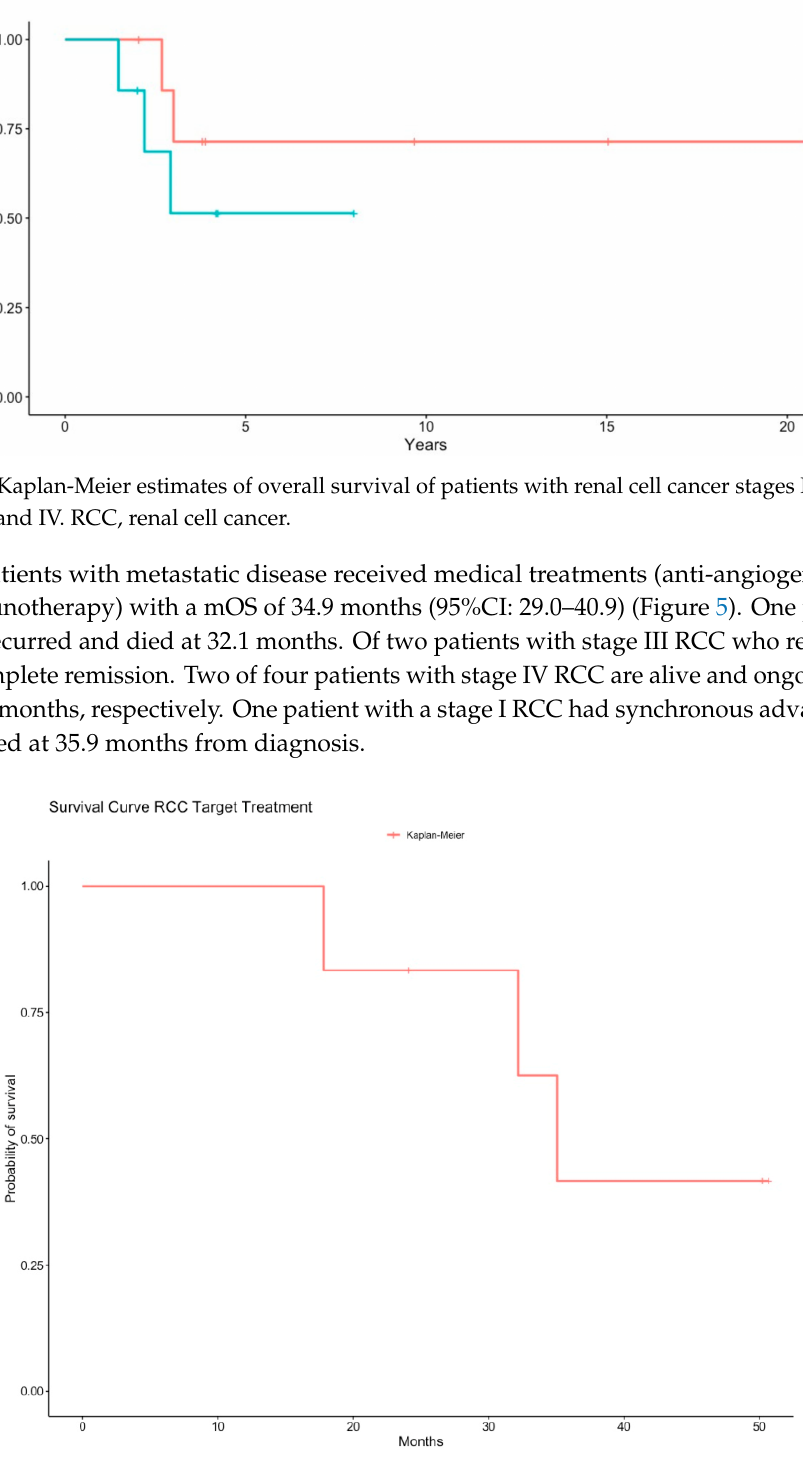
Figure 5. Kaplan–Meier estimates of overall survival of renal cell cancer in patients treated with target treatment (anti-angiogenic and immunotherapy). RCC, renal cell cancer.